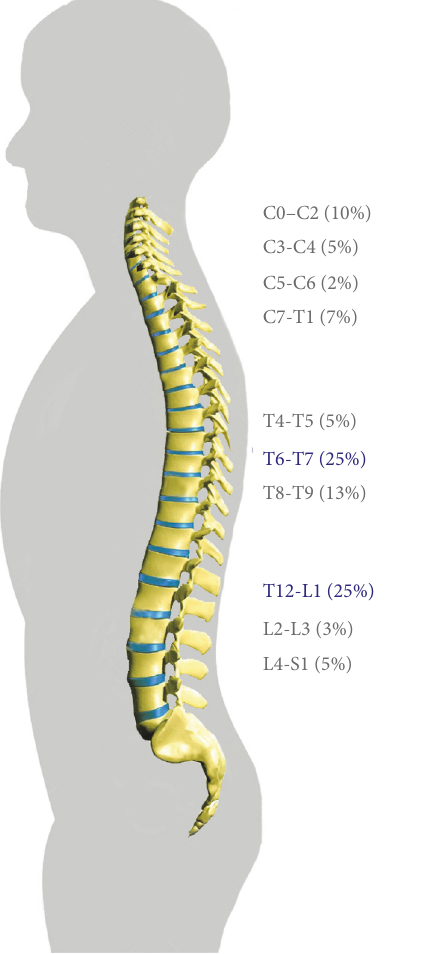
Figure 7: Repartition of vertebral somatic dysfunctions at recovery (R + 0) just after 3-day dry immersion (DI). The thoracolumbar (T12-L1) and thoracic (T6-T7) would be more frequently concerned after DI.